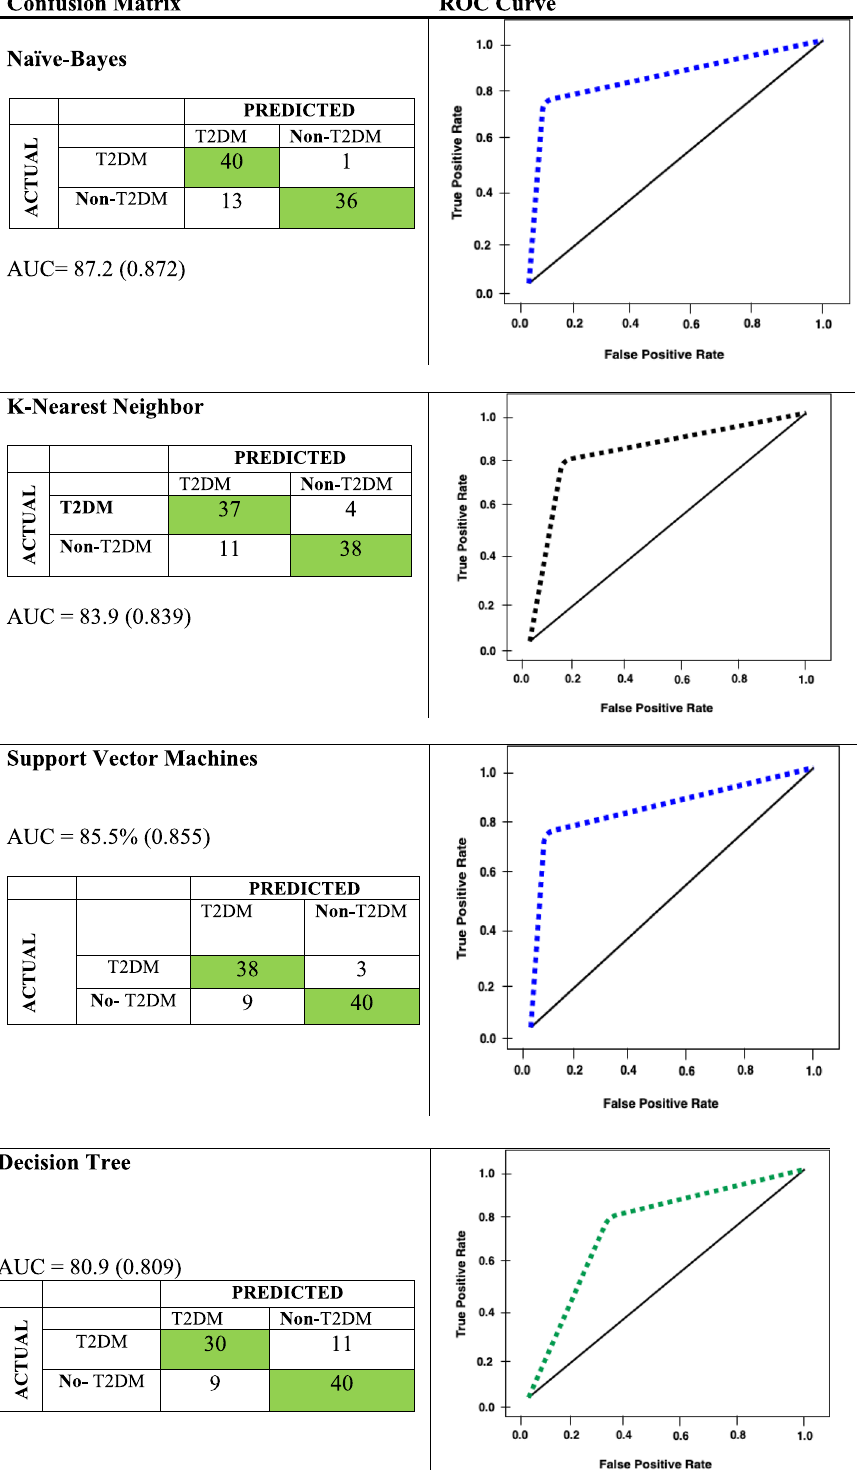
Table 3 Confusion Matrix and ROC curve for each of the